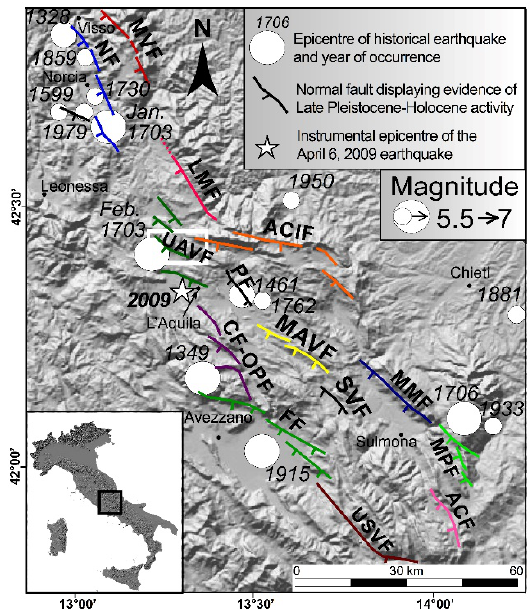
Fig. 2: Active faults of the central Apennines and epi- centres of large historic earthquakes (faults: MVEF, Mt. Vettore; NFS, Norcia; LMF, Laga Mts.; UAVFS, upper Aterno Valley; CIFS, Campo Imperatore; CF-OPF, Campo Felice-Ovindoli-Pezza; MAVFS, middle Aterno Valley; SVF, Subequana Valley; MMF, Mt. Morrone; FF, Fucino; MPF, Maiella-Porrara (Pizzi et al., 2010); ACF, Aremogna- Cinquemiglia; USFS, upper Sangro Valley). White rectan- gle defines the area in Fig. 4. Modified after Falcucci et al. (2011) and references